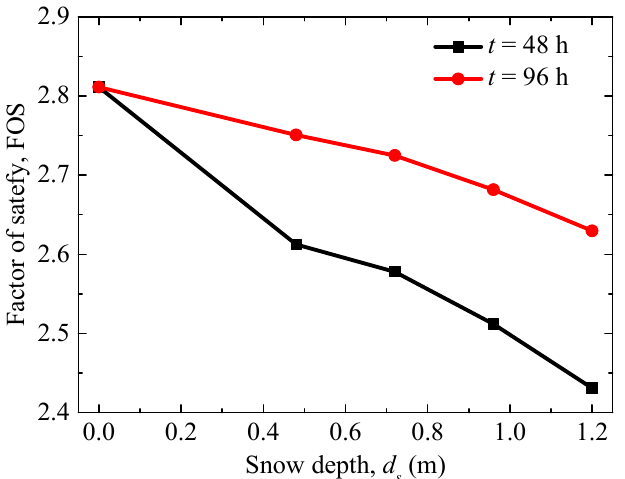
Figure 13. Factor of safety (FOS) of the cutting slope with the depth of accumulated snow ( d s ).